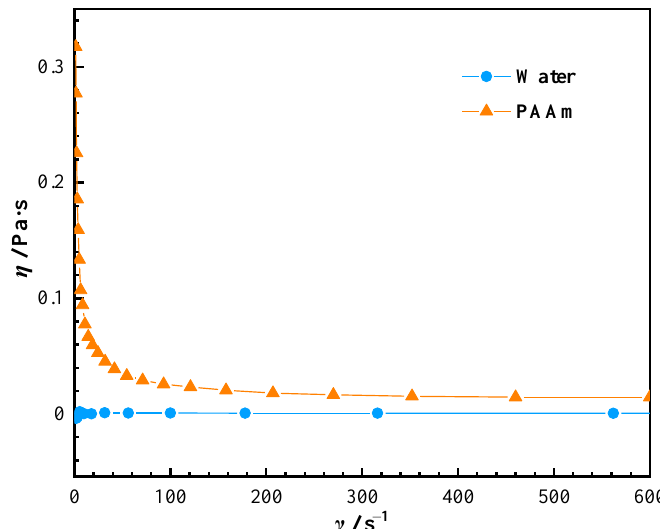
Figure 4. Dynamic viscosity for the 0.5 wt% PAAm solution as a function of the shear rate.